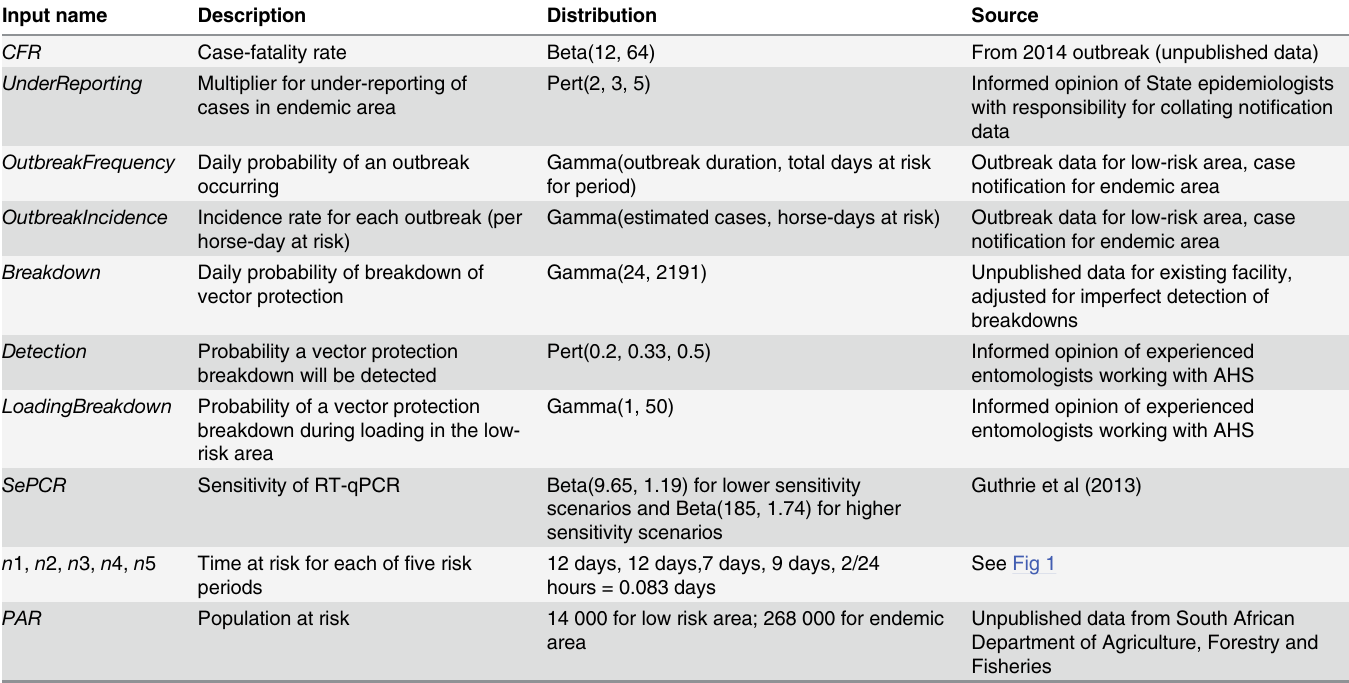
Table 3. Input distribution and other parameters for an AHS quantitative risk model.